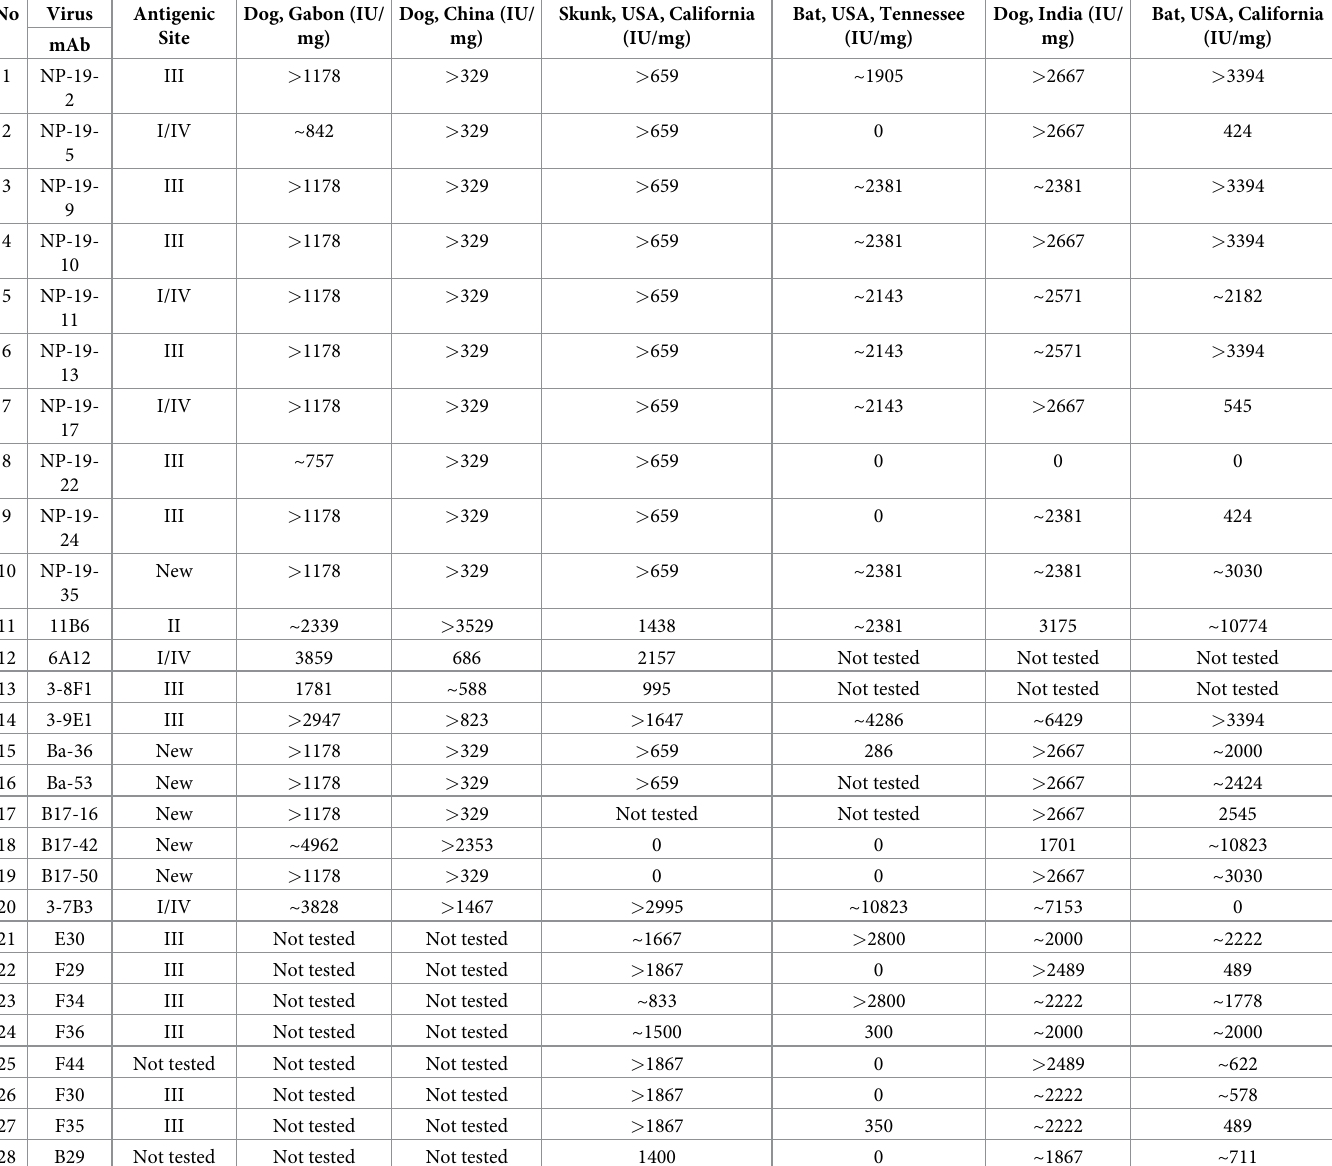
Table 1. The results of primary screening with six rabies viruses using